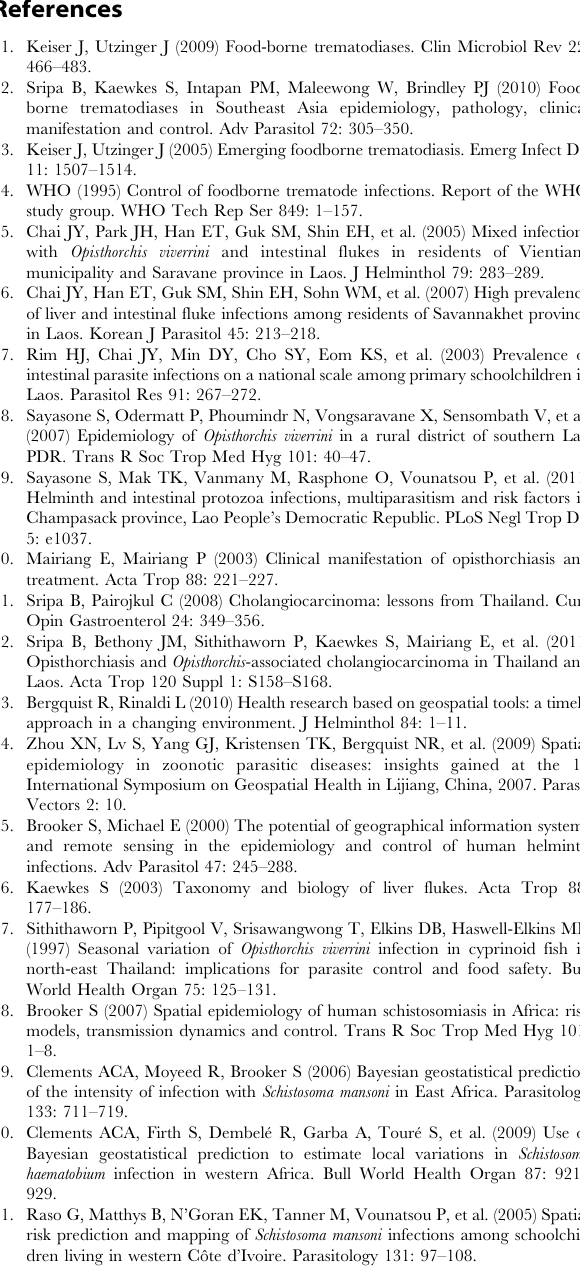
Table S1 Temporal and spatial resolutions of the environmental covariates used in the analysis. Table S2 Nomenclature for spatial and non-spatial models, with and without adjustment for treatment. Table S3 Results for non spatial bivariate regressions. Table S4 Goodness of fit (DIC) of non-spatial and correspond- ing spatial